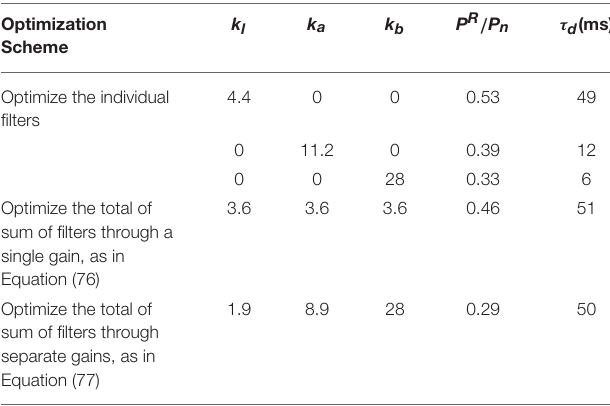
TABLE 4 | Optimal parameters computed for T en filters, when stimulated with white noise of bandwidth 30 Hz and total power P n . Optimization